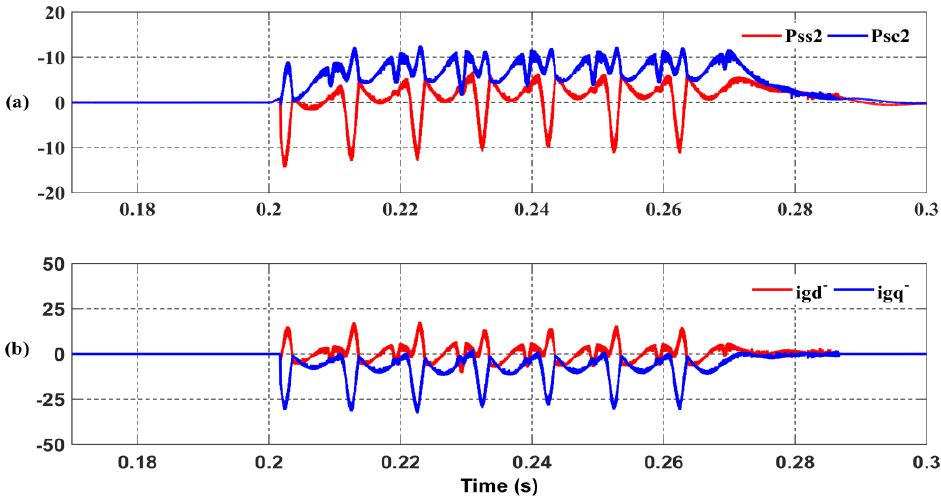
Figure 7. Simulation A results without dual positive- and negative-sequence controllers: ( a ) P ss2 (kW) and P sc2 (V) components, and ( b ) i gd− (A) and i gq− (A). and P sc2 (V) components, and ( b ) i − (A) and i − gq (A). gd